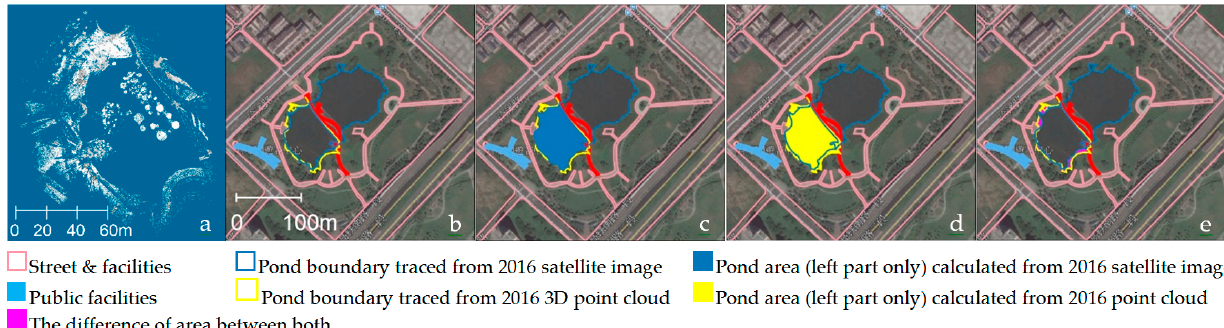
Figure 14. The illustration of the two types of boundary: ( a ) the projection of the 3D point cloud; ( b ) the Blue Pond in the yellow color boundary and 2016 Google Earth Pro® image in the blue color boundary; ( c ) blue boundary: 4635.26 m 2 ; ( d ) yellow boundary: 5332.86 m 2 ; ( e ) pink boundary: 697.6 m 2 in 15% tolerance. Table 3. Annual alternations of pond water area based on satellite images.